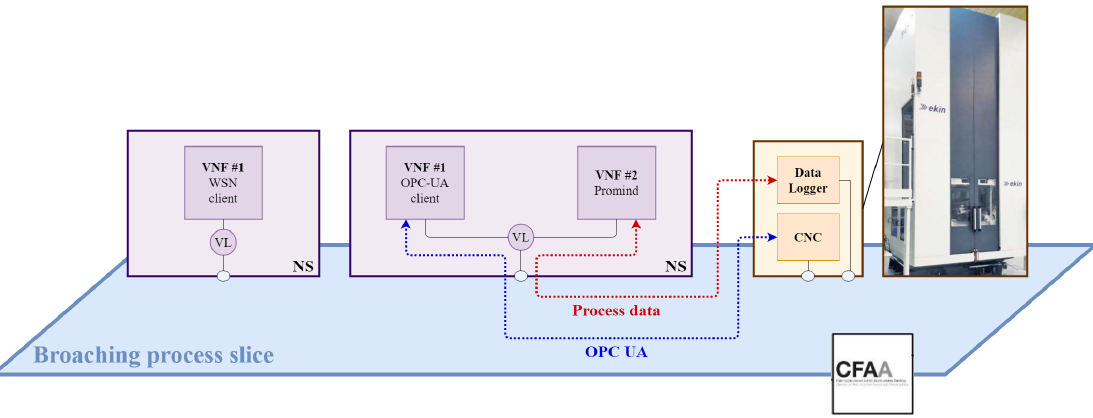
Figure 8. Broaching process